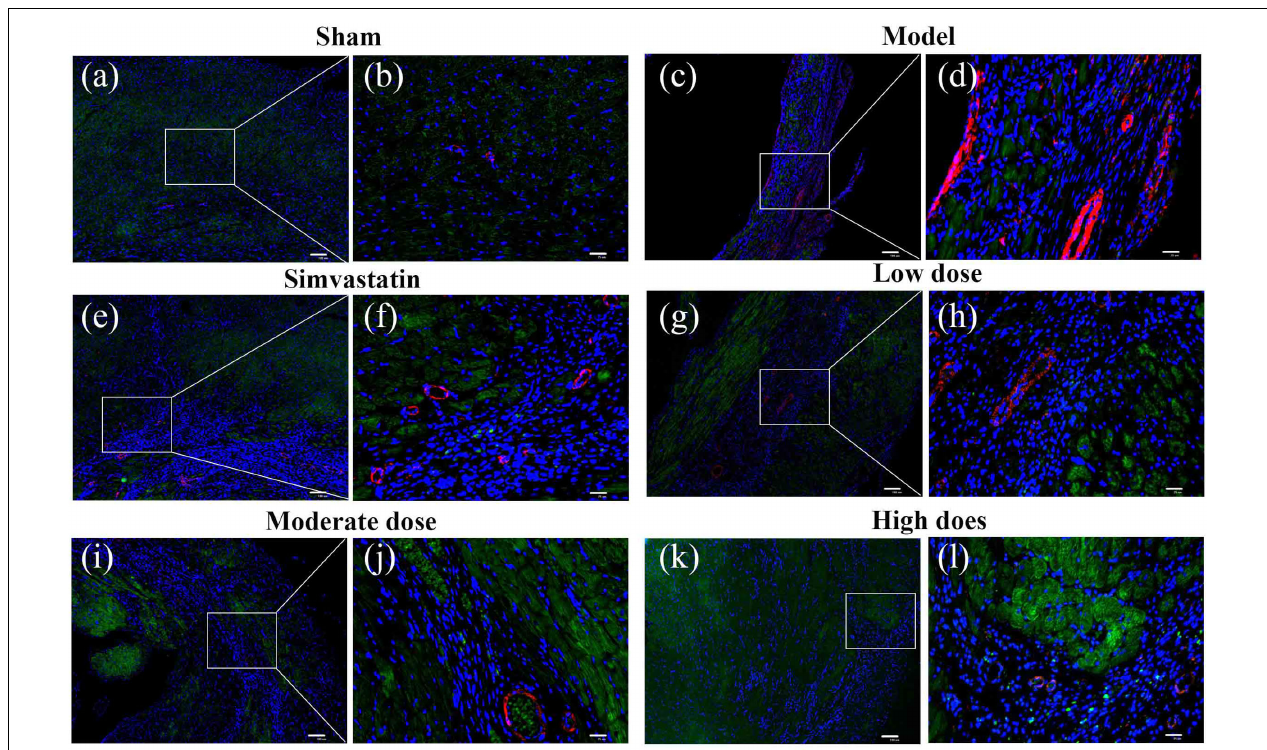
FIGURE 10 | Representative distribution images of ER β and α -SMA in rats treated with different doses of GXDSF. Immunofluorescence micrographs showing the differences in the distributions of ER β and α -SMA in the infarct and per-infarct region in all experimental groups (a,c,e,g,i,k) . Bars represents 100 µ m. The right part of the figures (b,d,f,h,j,l) were augmented at 4-fold in the corresponding (the left) part of figures. In addition, the different quasi-colors were depicted for distinguishing ER β and α -SMA, in which blue represented nuclei, green represented ER β and red represented α